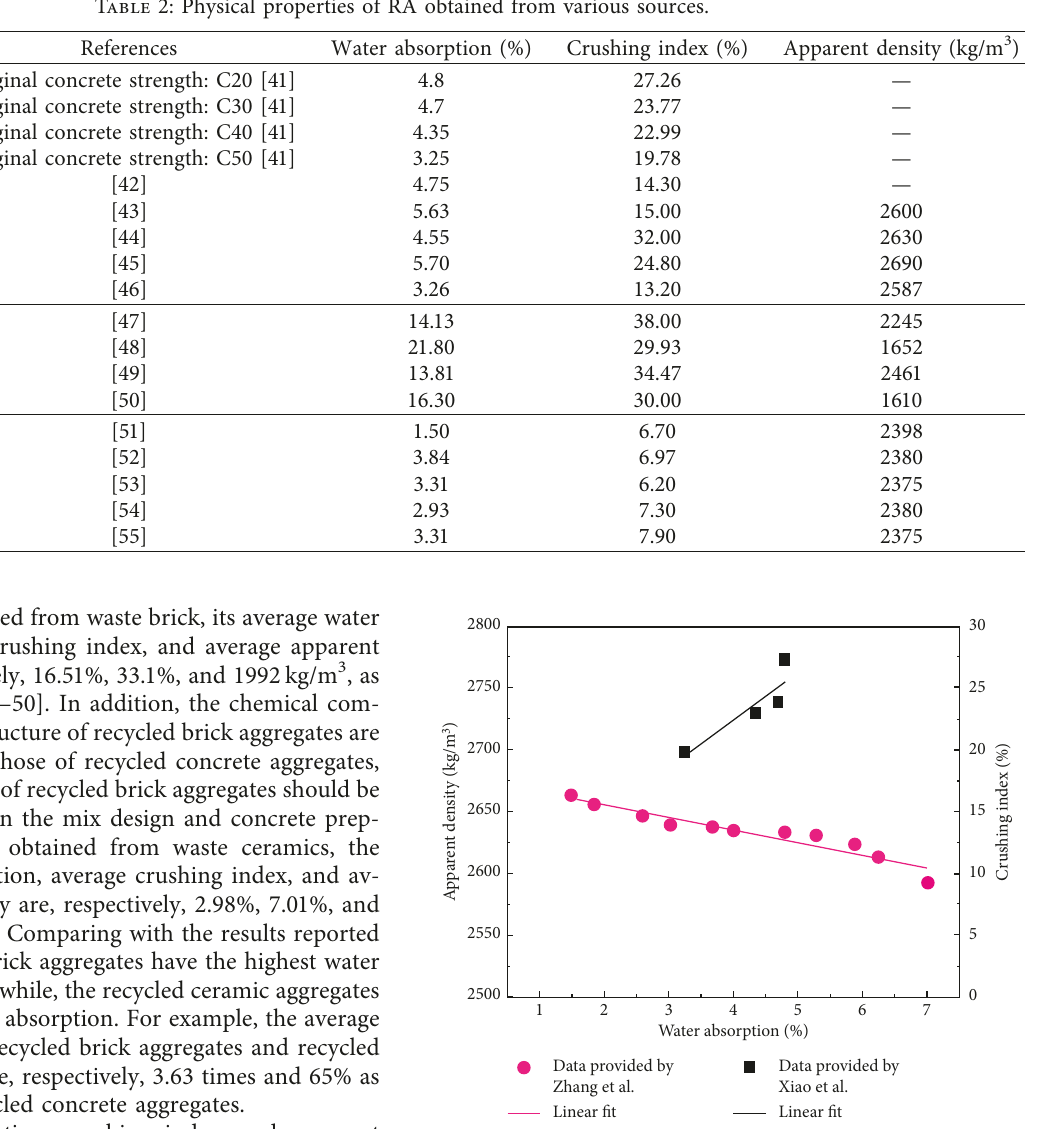
Figure 2: Relationship between the water absorption and apparent density or crushing index of RA [41, 43].